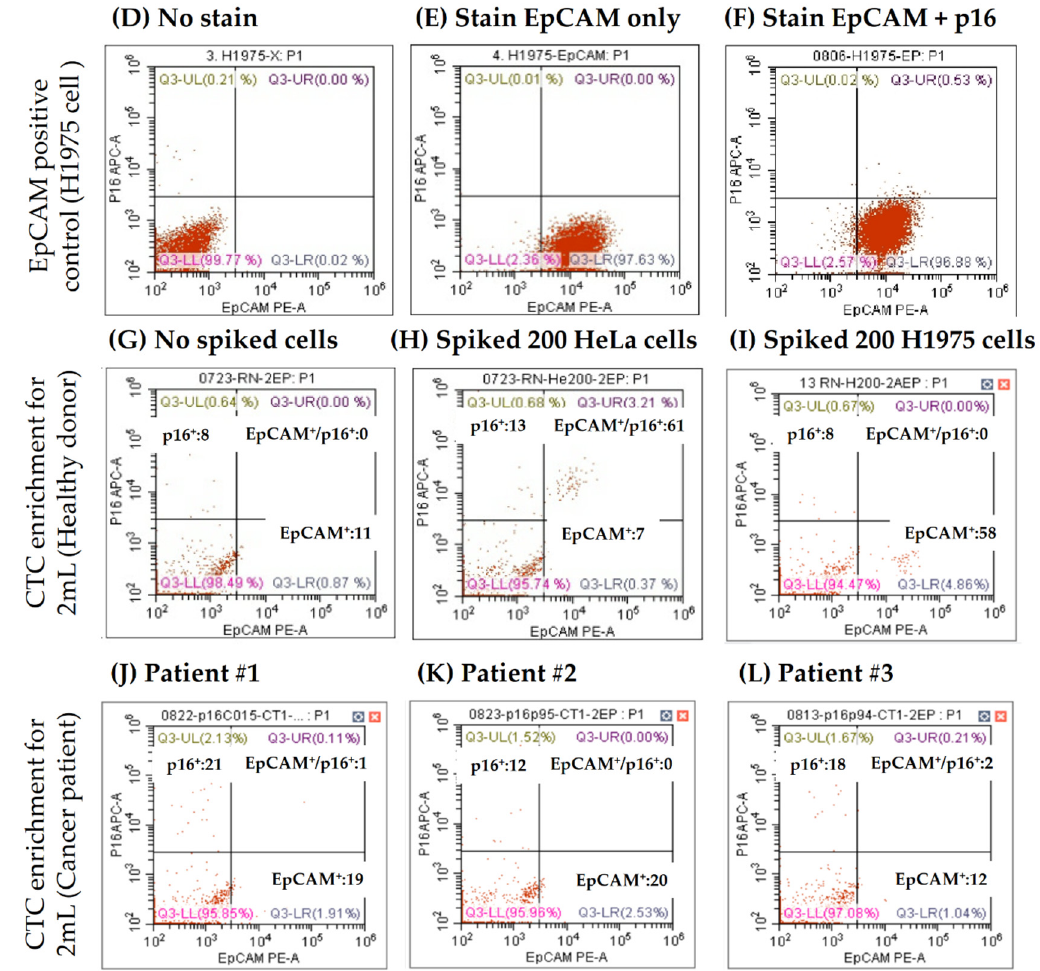
Figure 3. EpCAM+ and p16+ cell detection in blood samples. As standard controls, HeLa served as positive expression cells for flow cytometric analysis for p16 ( A – C ), and H1975 cells served as EpCAM expression ( D – F ). Accordingly, the protocol with controls can demonstrate p16 expression status in circulating tumor cells in one healthy individual by spiking different control cell lines ( G – I ) and three cancer patients ( J – L ).